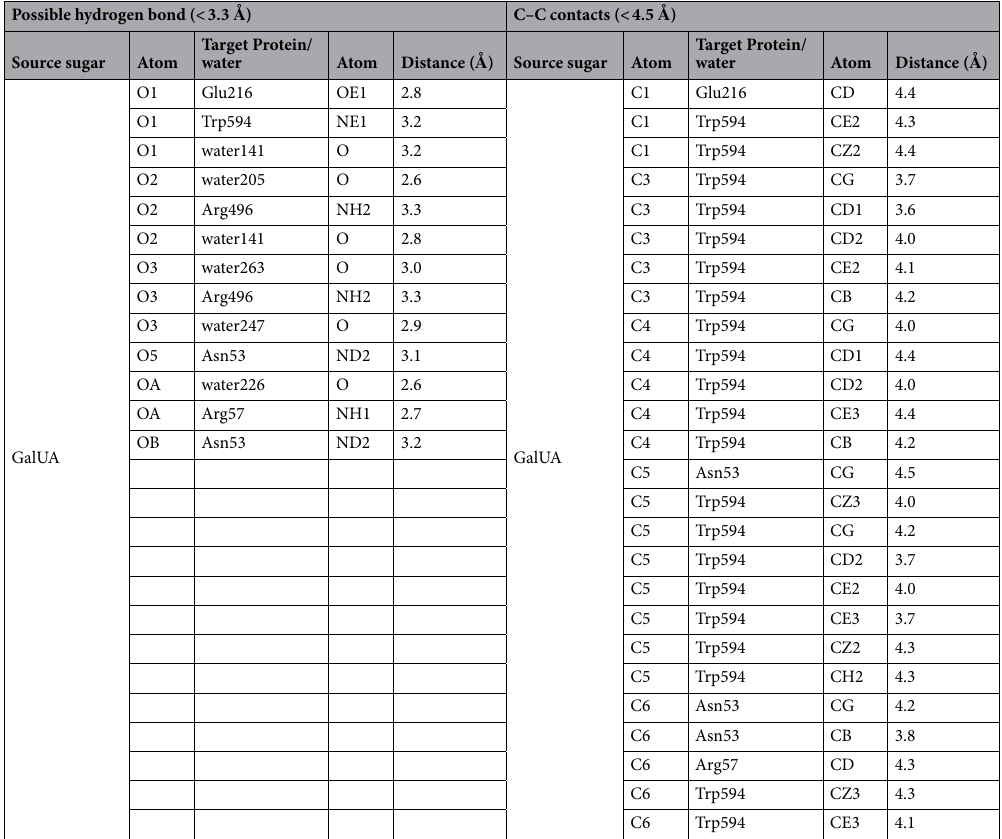
Table 2. Interactions in SPH1118/GalUA between SPH1118 and GalUA.